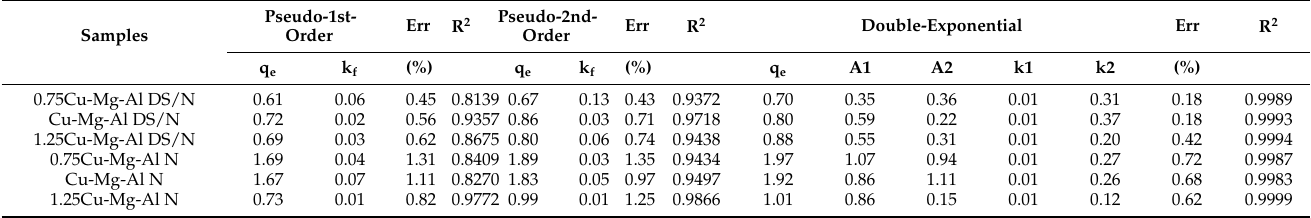
Table 4. Parameters of CO 2 kinetic models, R 2 , and standard errors (%) for xCu-Mg-Al N and xCu-Mg-Al DS/N at 30 ◦ C and 1